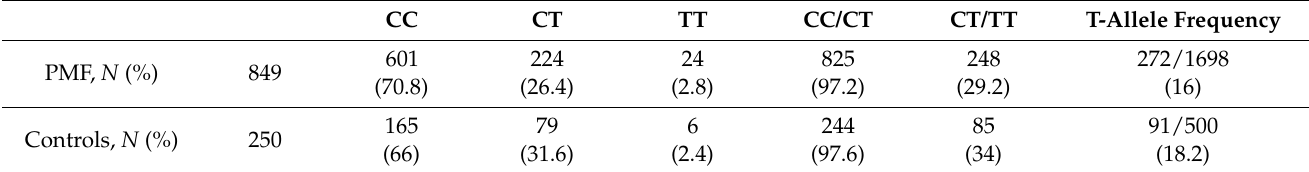
Table 2. VEGFA rs3025039